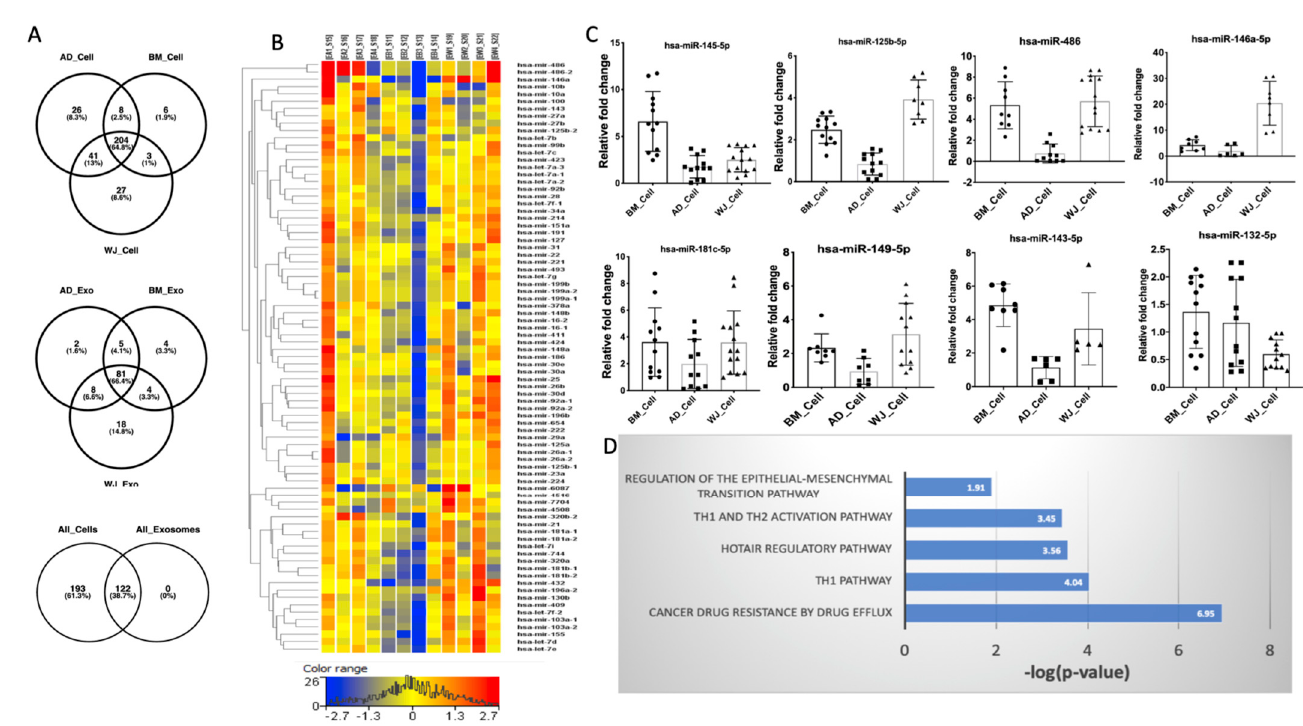
Figure 2. The miRNAs’ profiling of hMSCs and their exosomes. ( A ) Total number of miRNAs detected and commonly present in hMSCs and exosomes. ( B ) Heat map of a total of 81 miRNAs expressed in all three different sources of exosomes. EA = Exosomes Adipose tissue, EB = Exosomes Bone marrow, EW = Exosome Wharton Jelly; 1, 2, 3, and 4 represent different donors. ( C ) Validation of the top miRNAs present in hMSCs. ( D ) Processes and pathways targeted by the most abundant miRNAs.